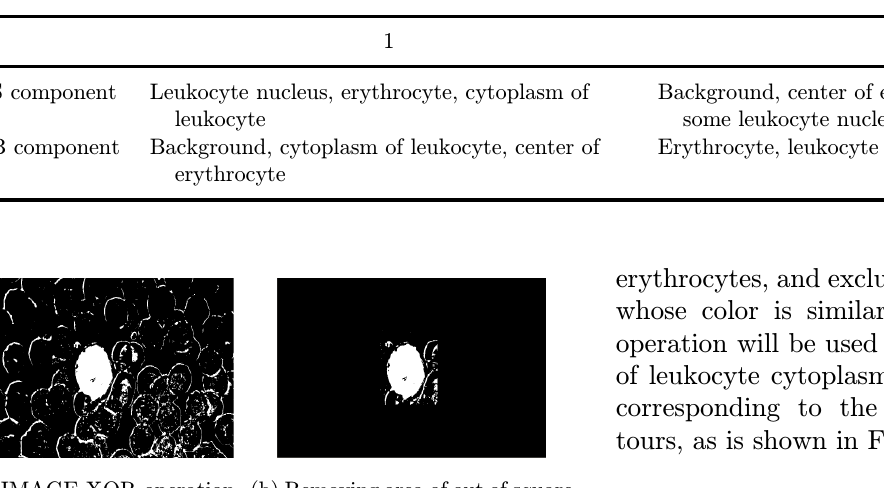
Table 1. Comparing the binary picture of B component of with S component.